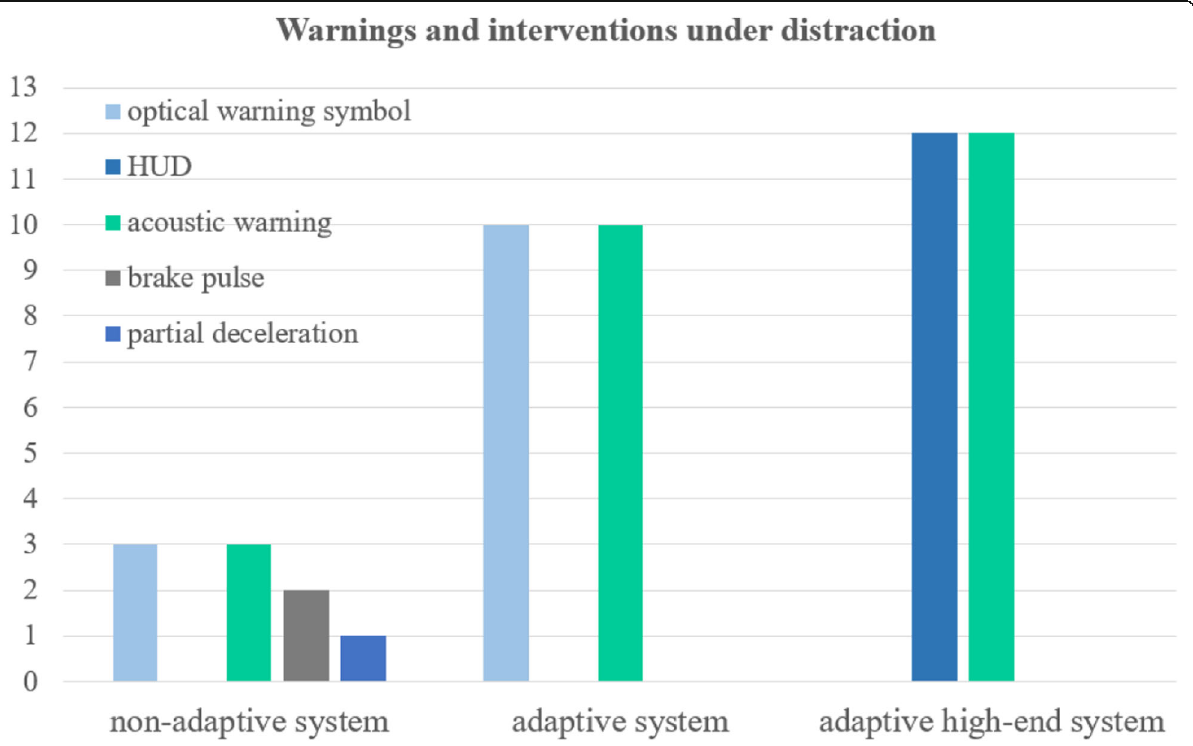
Fig. 11 Evaluation of the warning and intervention frequency under